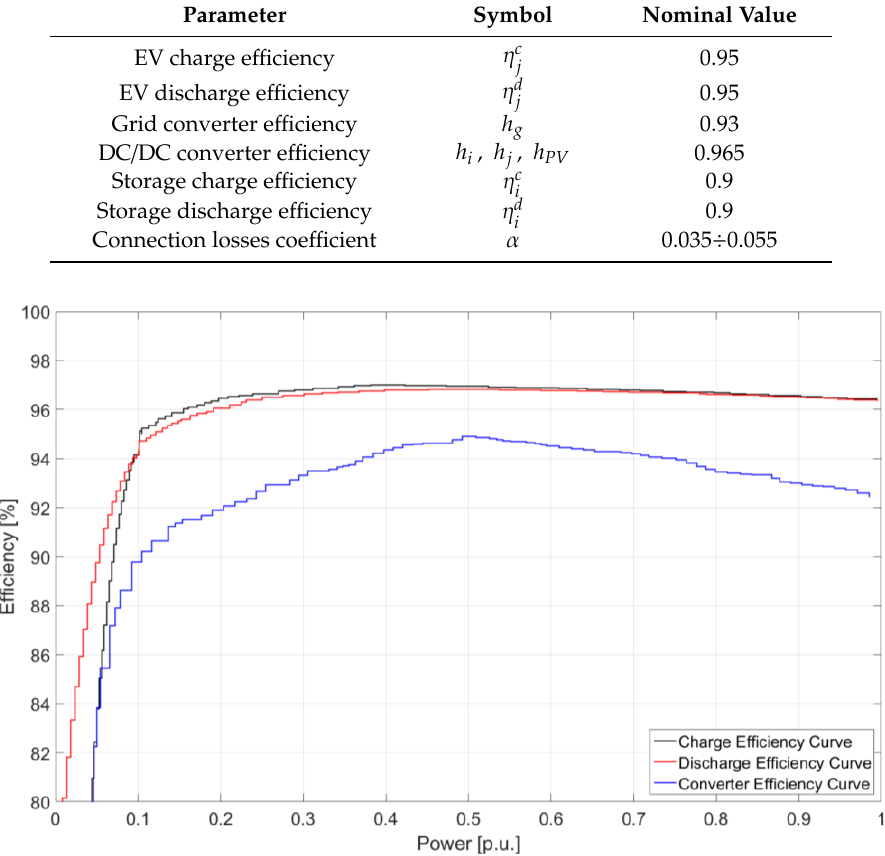
Figure 5. Forecasted EV exploitation patterns on the three different days.